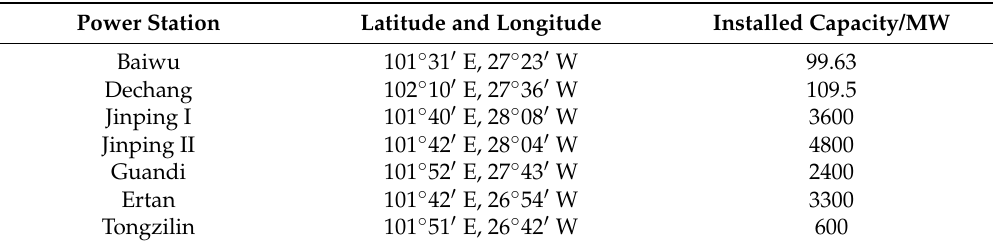
Table 2. Information about the selected power